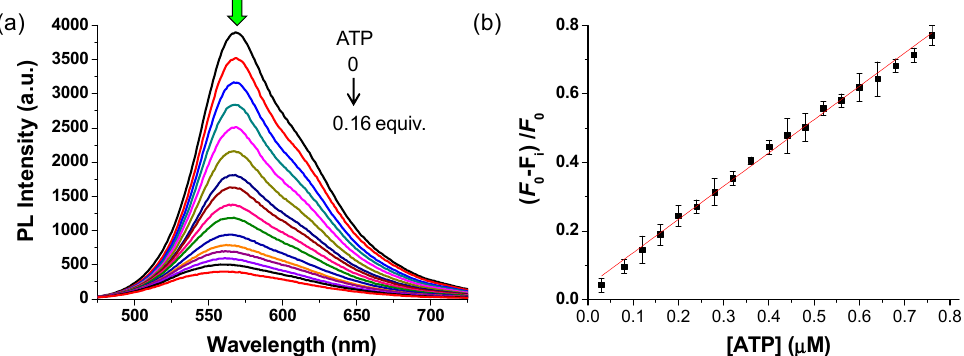
Figure 5. ( a ) Fluorescence spectra of L (10 μ M) with the addition of various concentrations of ATP in tris -HCl buffer solution (10 mM, pH 7.4); ( b ) Plot of ( F 0 − F i )/ F 0 at 570 nm vs. concentrations of ATP. F 0 is the initial emission intensity of L (10 μ M), and F i is the recorded emission intensities of L in the presence of ATP with different concentrations. Excitation wavelength: 450 nm. Error bars represent the standard deviations of three trials.